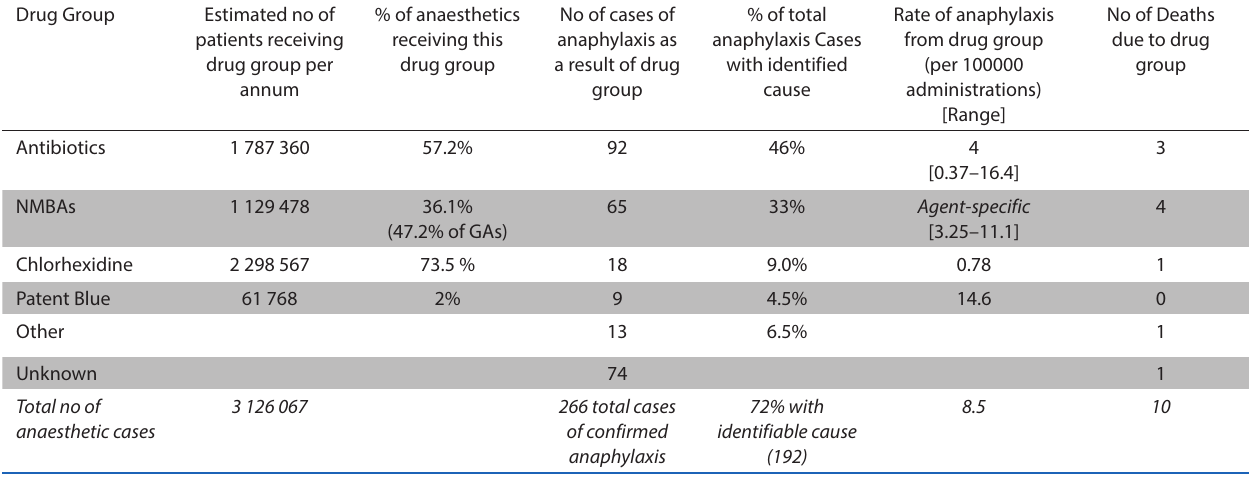
Table 1: Summary of Activity Survey, Allergen Survey and Perioperative Anaphylaxis Causes in NAP6 2,22,26 Drug Group